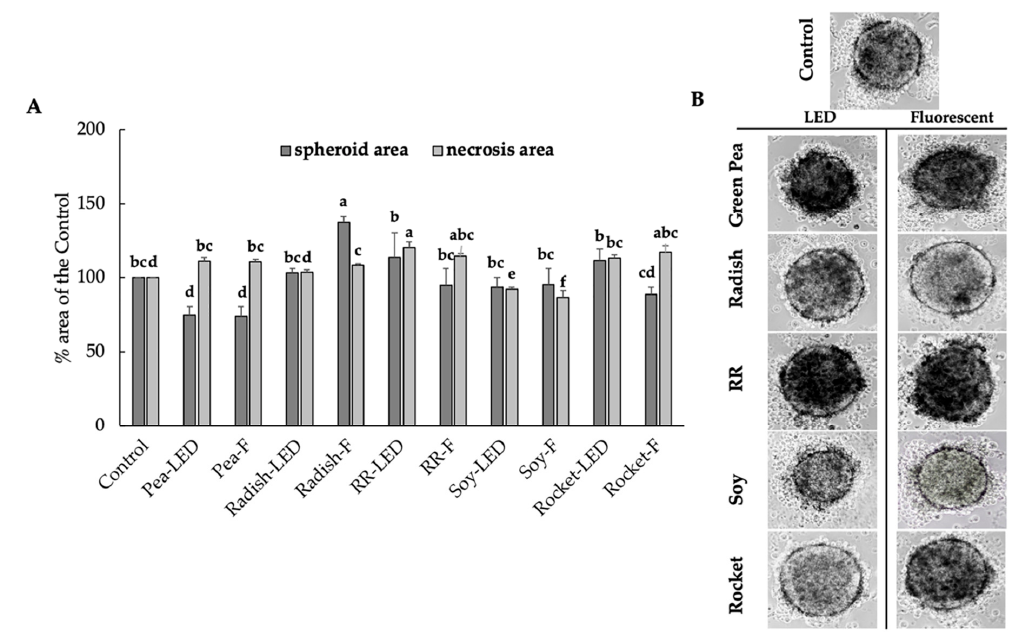
Figure 7. The anti-proliferative (spheroid area) and pro-apoptotic effects (necrosis area) ( A ) on RD-ES exposed for 120 h to 40 μ L green pea, radish, Red Rambo (RR), soybean (soy), and rocket microgreens, cultivated under LED and fluorescent (F) lighting. Values are the mean ± SD of six replicates ( n = 6). The different lowercase letters (a–f) represent significant differences for the microgreen species under different lighting ( p < 0.05), as determined from a one-way ANOVA for spheroid area and necrosis area, respectively. Associated images showing pro-apoptotic effects (necrosis area) of RD-ES are shown ( B ).